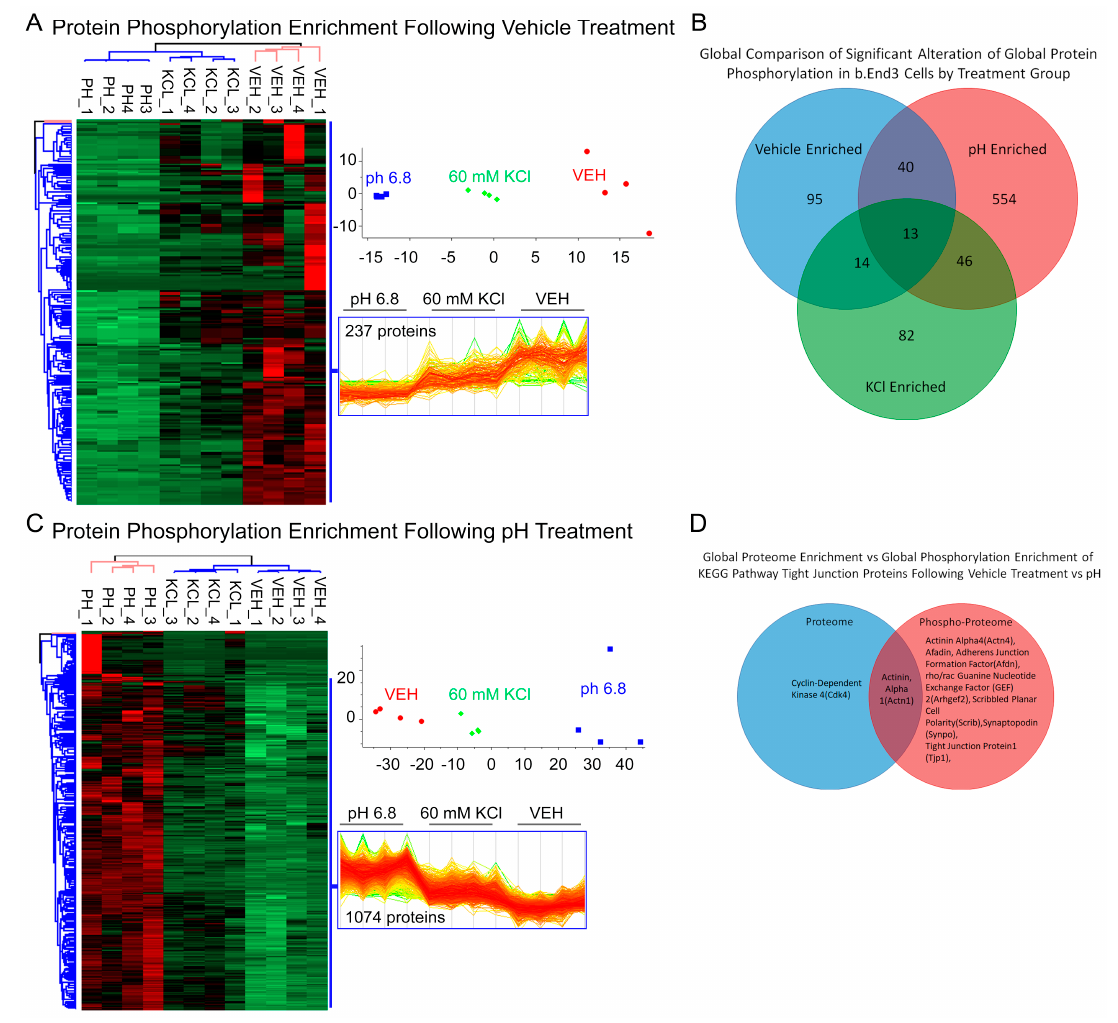
Figure 6. Global phospho-proteomic analysis of b.End3 endothelial cells following exposure to 60 mM KCl, acidified media buffered to pH = 6.8, and vehicle demonstrates variable phosphorylation enrichment of protein targets unique to each individual treatment, indicative of unique mechanisms of phosphorylation induction identifiable to each individual treatment. ( A ) Unbiased hierarchal clustering and principal component analysis of the 237 proteins experiencing phosphorylation enrich- ment following vehicle treatment when compared to KCl and acidified pH treatment, significance assessed by 3-way ANOVA ( α = 0.05) analysis of global phospho-proteome data illustrating con- sistent phosphorylation enrichment between each biological sample ( n = 4 per treatment group) clustering into vehicle, 60 mm KCl, and acidified media treatment groups. Heat map visualizes individual protein clustering. ( B ) Venn diagram comparing total protein phosphorylation enrichment by treatment group; enrichments can be largely identified with a single treatment, small degree of overlap due to large sample pool and ubiquitous nature of peptide phosphorylation. ( C ) Unbiased hierarchal clustering and principal component analysis of the 1074 proteins undergoing phosphoryla- tion enrichment post exposure to acidified media compared to KCl and vehicle exposure; significance assessed by 3-way ANOVA ( α = 0.05) analysis of global phospho-proteome data demonstrating consistent phosphorylation enrichment between biological samples ( n = 4 per treatment group) with each protein clustering into vehicle, 60 mM KCl, and acidified media treatment groups. Heat map visualizes clustering of individual proteins. ( D ) Venn diagram comparing vehicle induced enrichment of total expression and phosphorylation enrichment of tight junction proteins identified in the KEGG pathway bioinformatic database, indicative of tandem alterations to PTM and overall expression of TJ proteins isolated to an individual